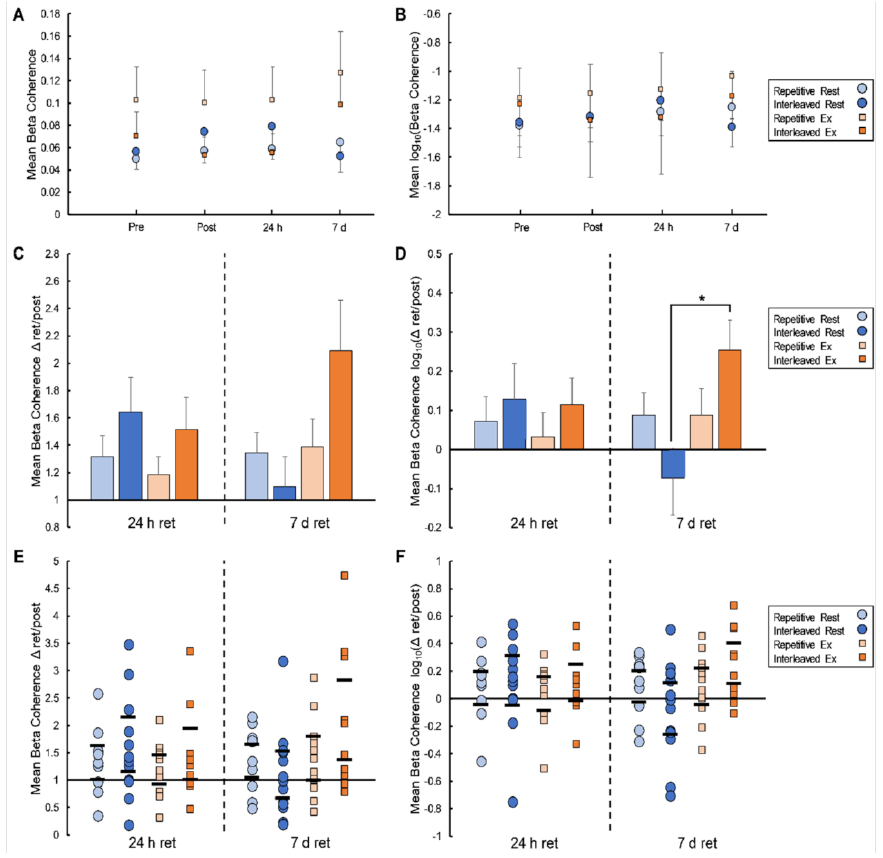
Figure 5. Intermuscular coherence results. Panels ( A , B ) depict raw ( A ) and log-transformed ( B ) intermuscular beta coherence data when averaged across participants in each group for each time point. Panels ( C , D ) show average change in mean beta coherence ( C ) and log-transformed mean beta coherence ( D ) over the consolidation periods for each group, with coherence at each retention test expressed as a ratio relative to post-practice coherence. Error bars in panels ( A – D ) reflect standard error. Asterisks (*) in panels ( C , D ) denote statistically significant differences between groups. Panels ( E , F ) show individual data points contributing to the group averages in ( C , D ). Horizontal lines in panels ( E , F ) represent 95% confidence